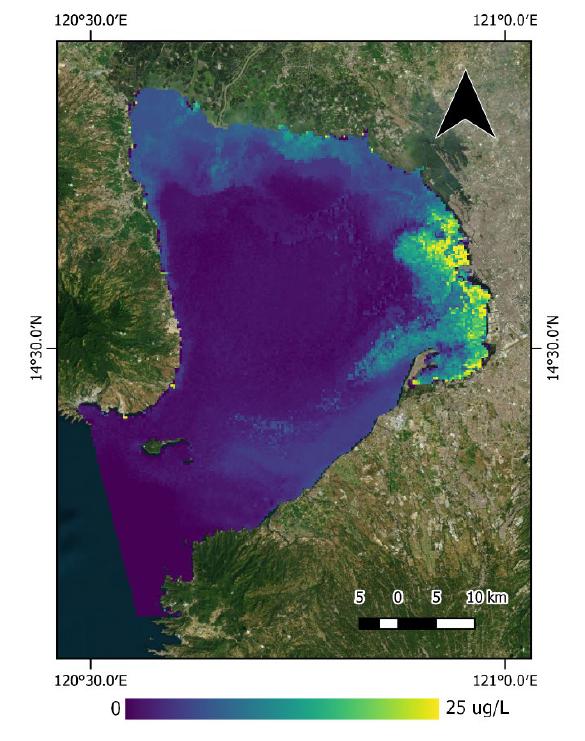
Figure 4. C2RCC Chlorophyll-a (March 29, 2020)